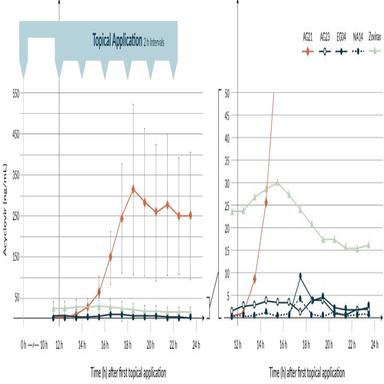
ACV pharmacokinetic profiles. Left: profiles for the four selected test formulations and the reference product Zovirax® 5% cream. Right: detailed depiction of ACV concentrations from 0 to 50 ng/mL.